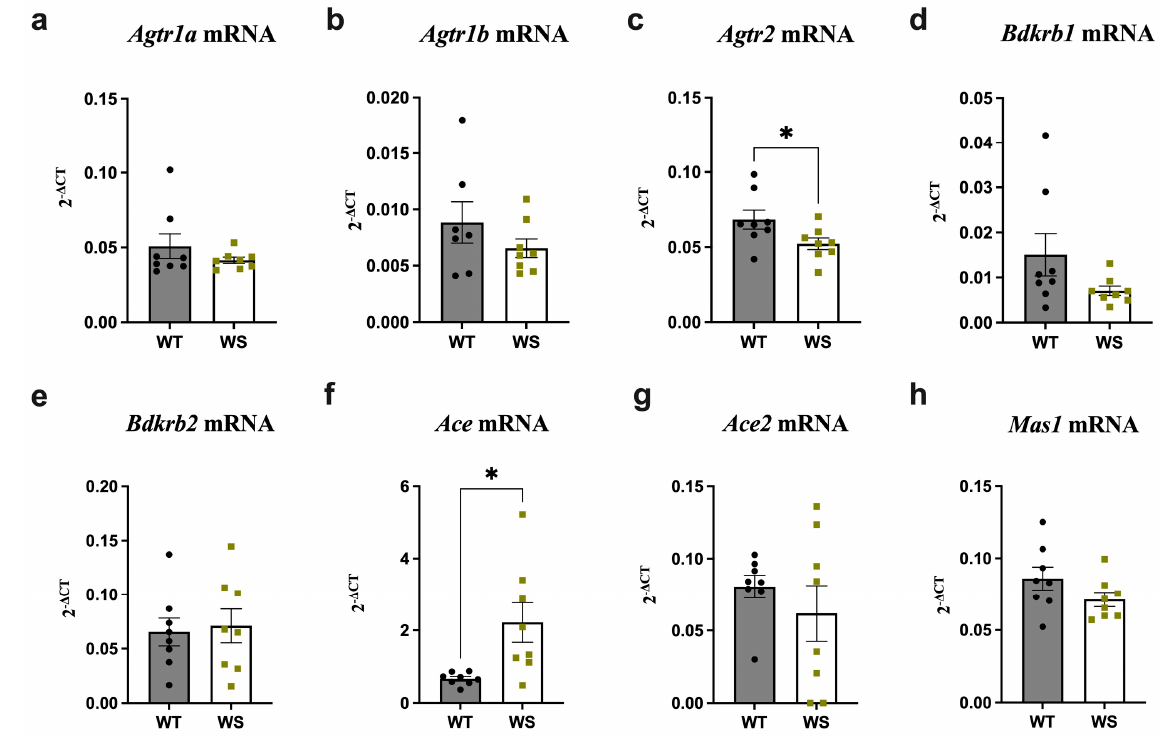
Figure 4. Significant upregulation and downregulation of Ace and Agtr2 , respectively, was noted in the brain stems of treatment-naïve aged Wfs1 -deficient rats. Gene expression was analyzed from the brain stems of 12.5–13-month-old animals taken directly from their home cages. Relative gene expression levels of ( a ) Agtr1a , ( b ) Agtr1b , ( c ) Agtr2 , ( d ) Bdkrb1 , ( e ) Bdkrb2 , ( f ) Ace , ( g ) Ace2 and ( h ) Mas1 . Gene expression level is presented as 2 −Δ CT relative to the housekeeper Hprt . Statistical significance was determined using an unpaired t -test; * p < 0.05 The data are presented as mean ± SEM, n = 8 per group.